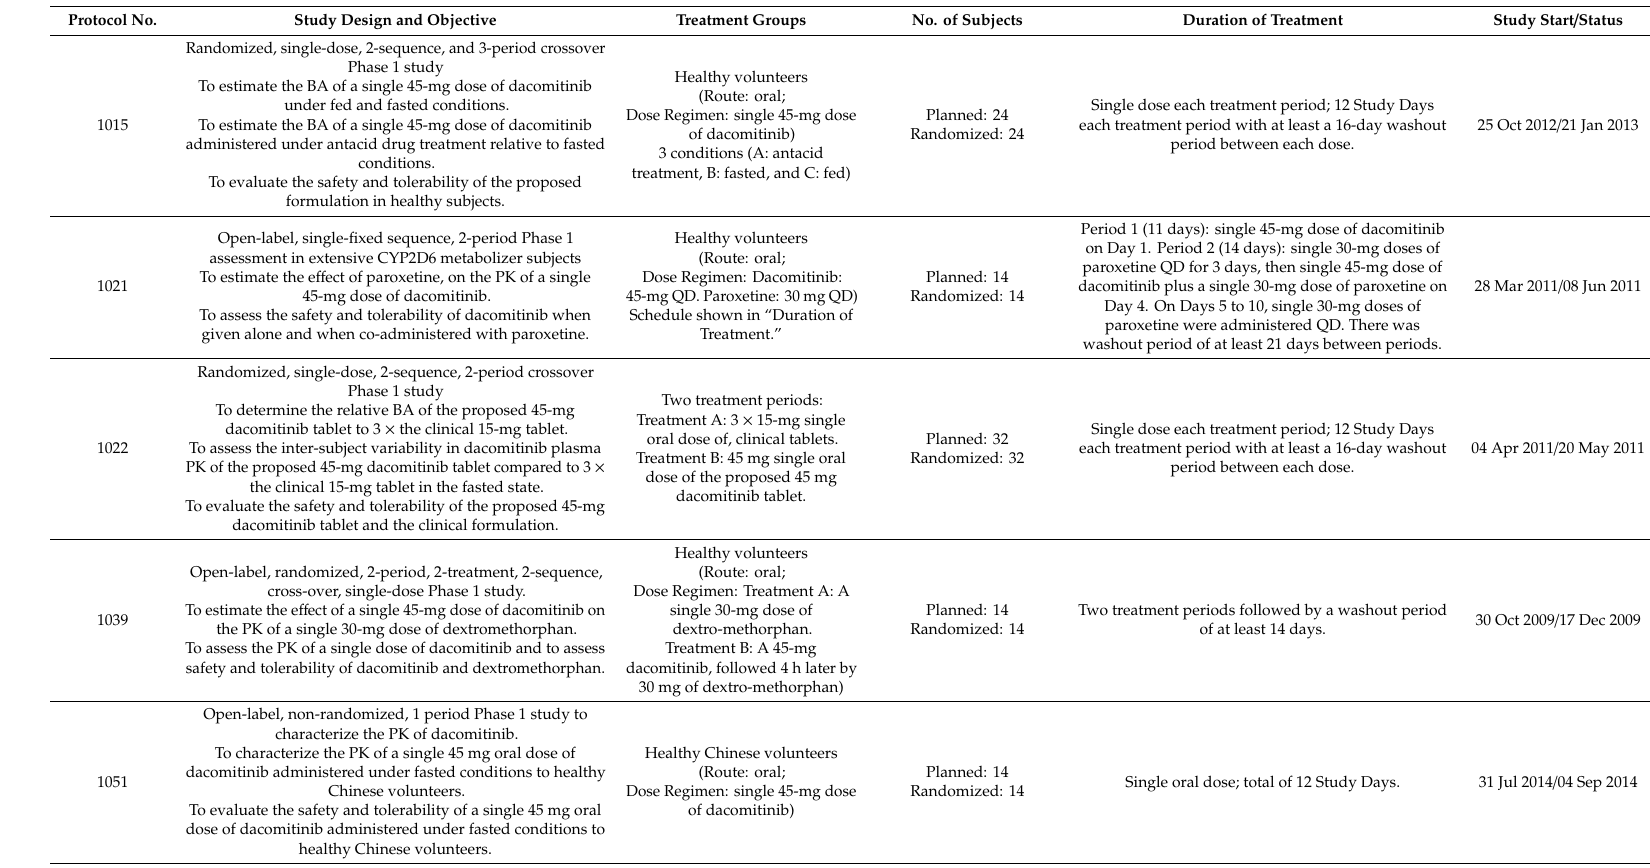
Table 1. Dacomitinib population PK pooled dataset—summary of